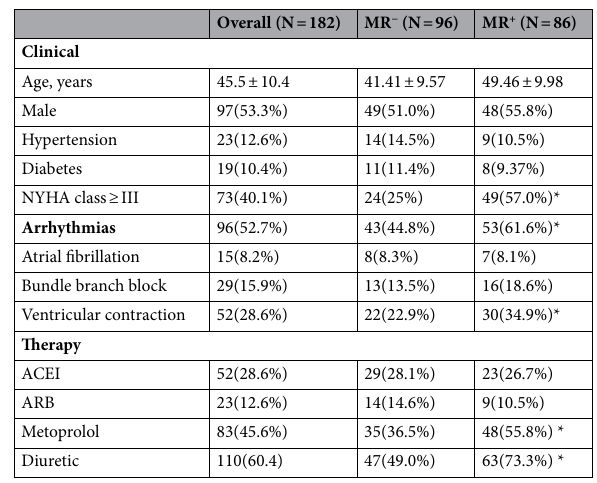
Table 1. The clinical characteristics of patients. *The statistical difference between MR − and MR + group. MR − patients without mitral regurgitation, MR + patients with mitral regurgitation, NYHA New York Heart Association, ACEI angiotensin converting enzyme inhibitors, ARB angiotensin receptor